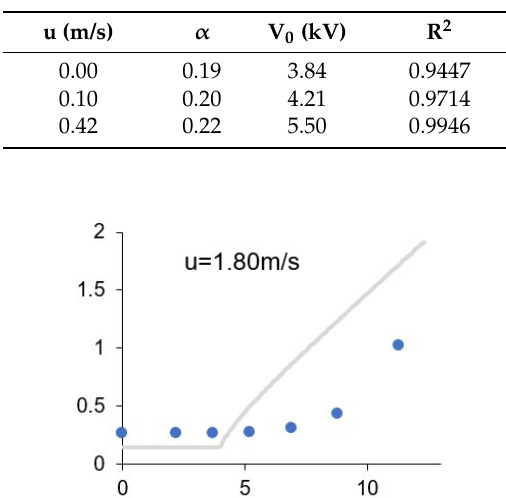
Figure 12. Experimental (blue dots) and fitted values (grey lines). Table 8. Values of the fitted parameters from Equation (7).